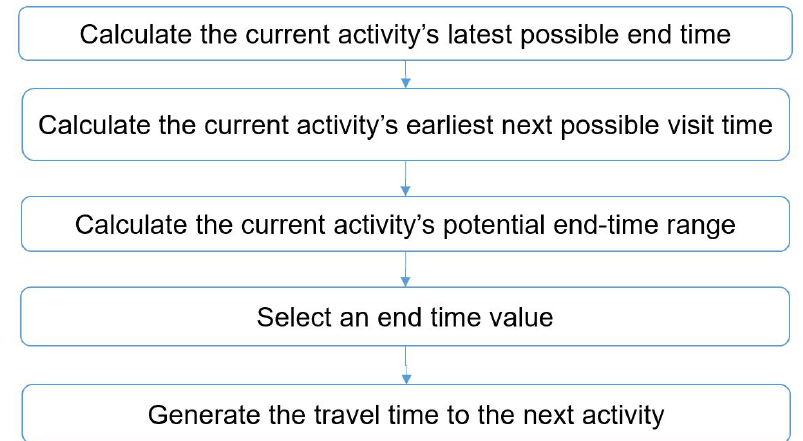
Figure 6. Time-choice flowchart.